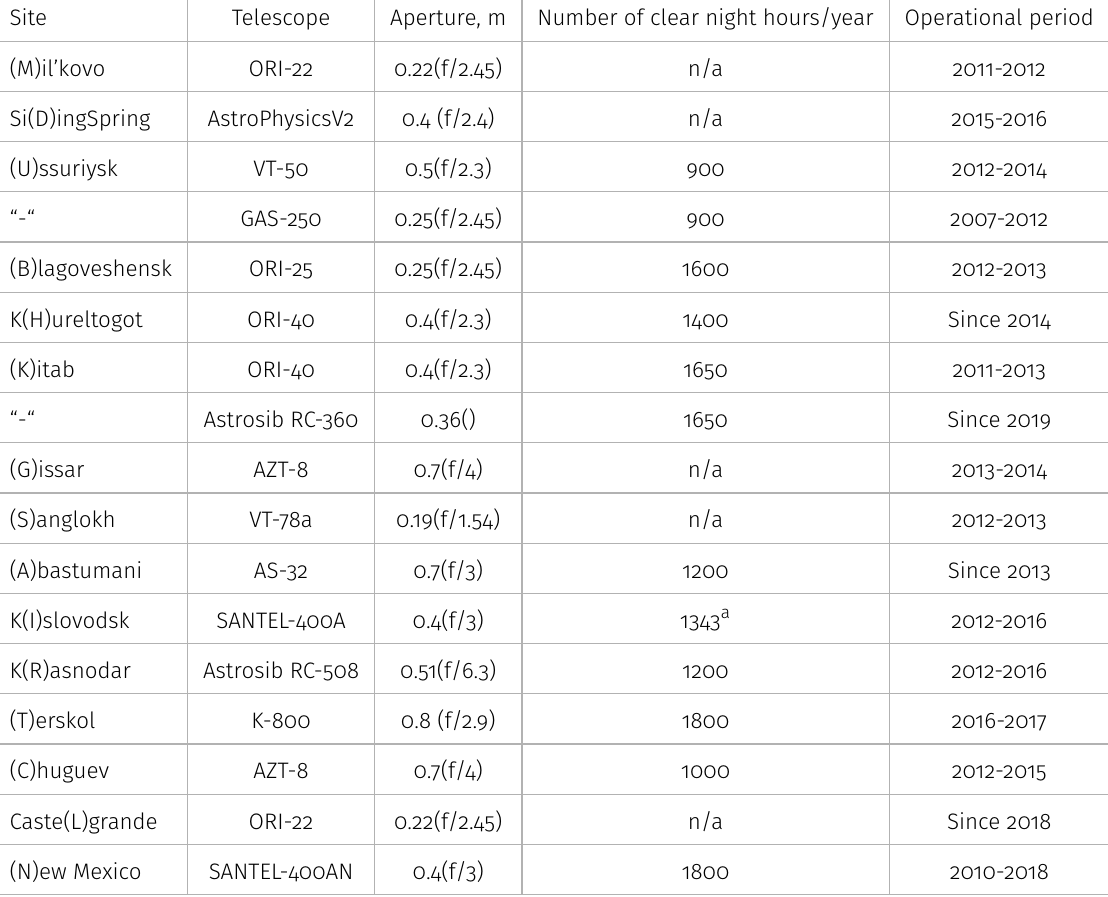
Table I. The list of ISON observatories with telescopes with apertures less than 1 meter, which collaborate with IKI GRB-FuN network. Asterisk mark observatories which are not operational at the time. a – taken from Kornilov et al.